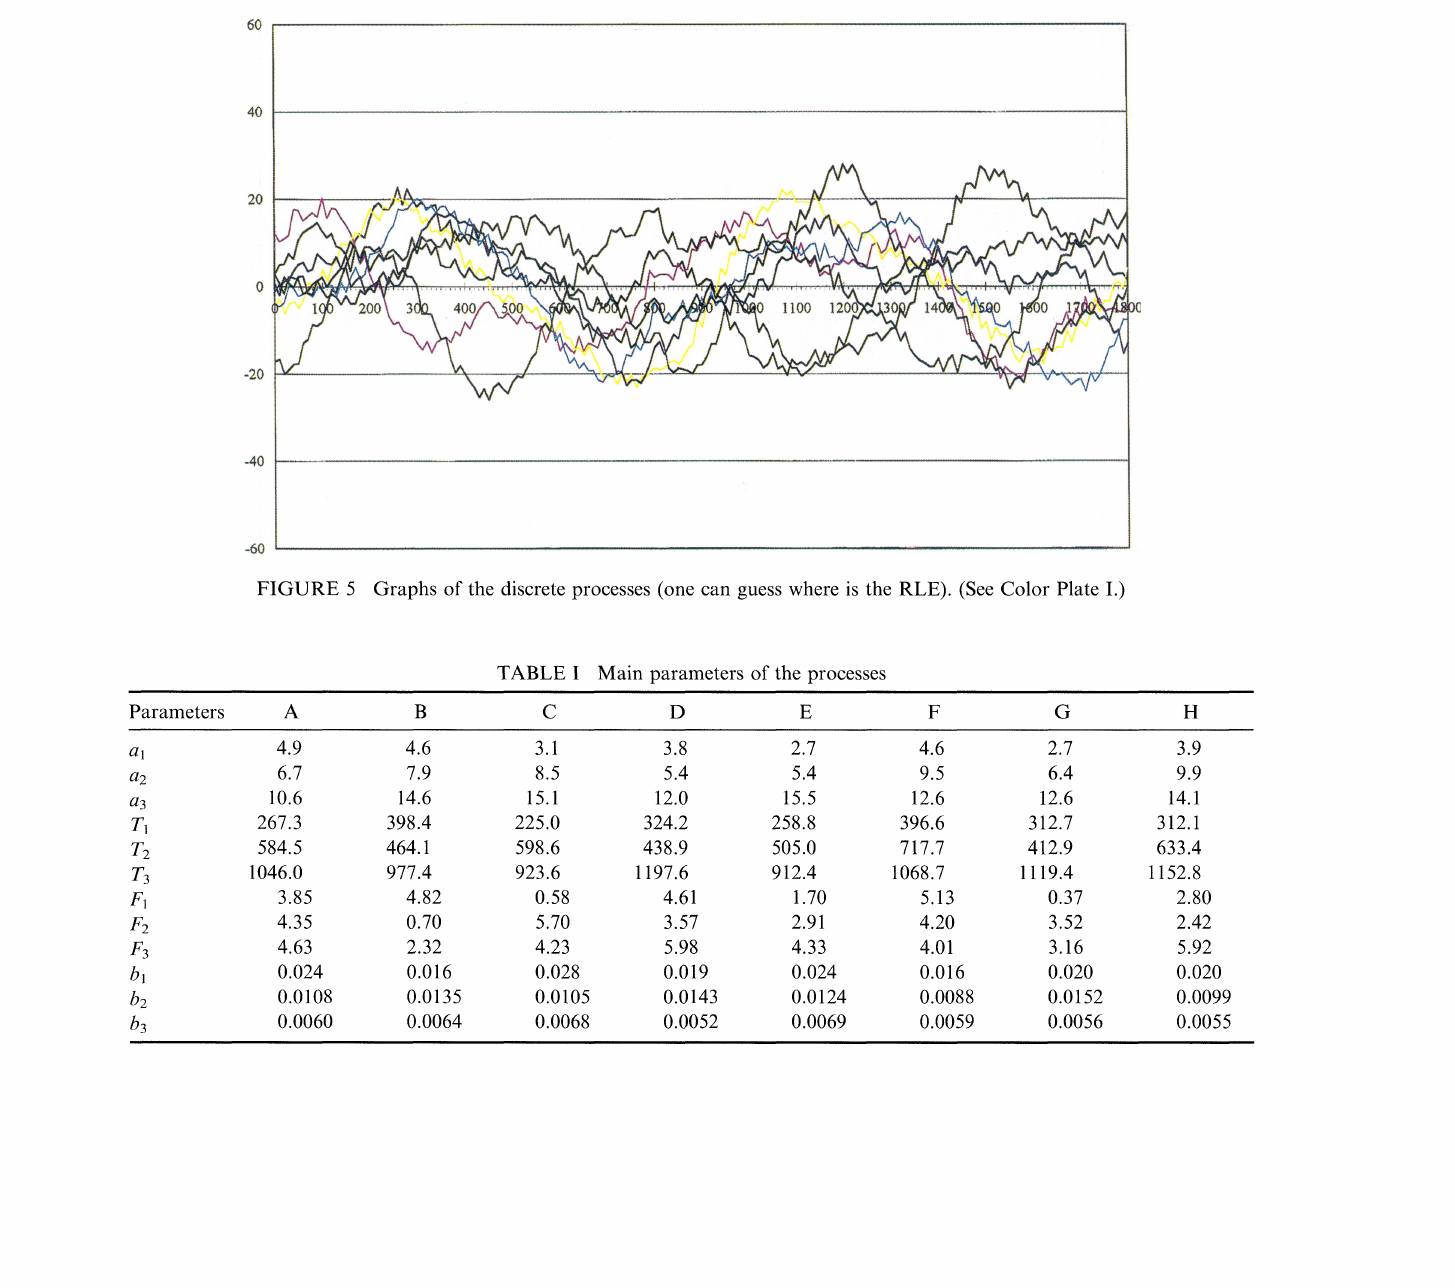
Main parameters of the